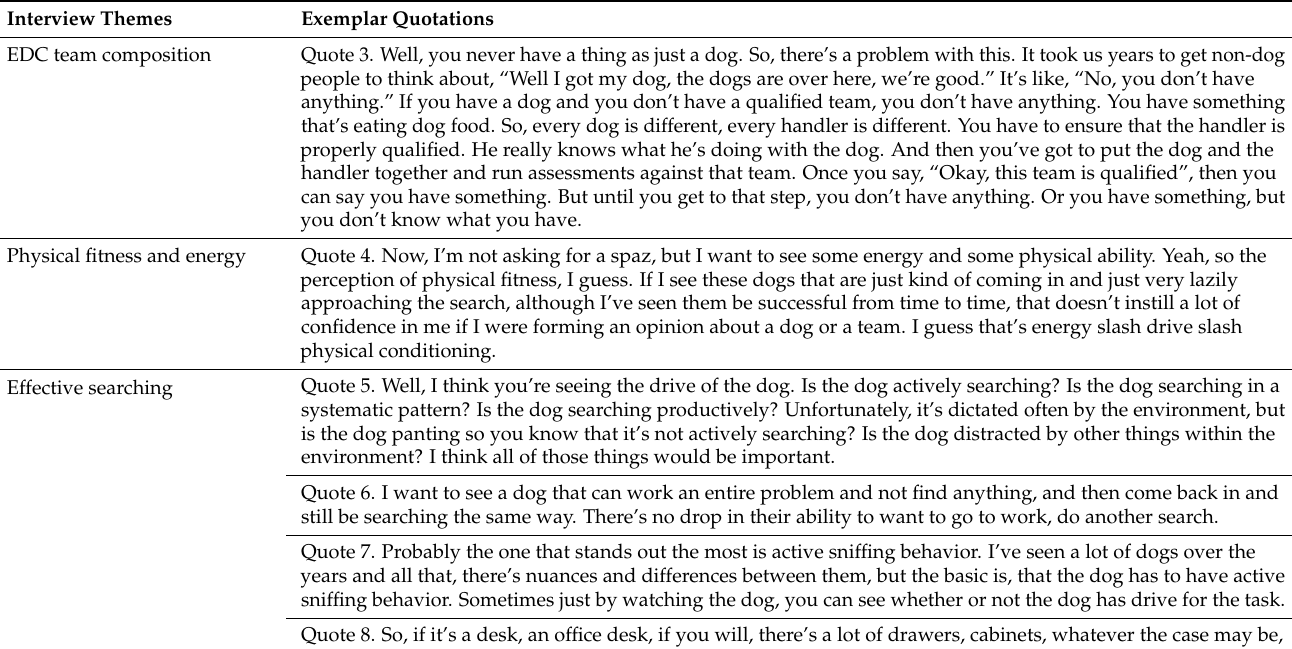
Table 2. EDC team performance interview themes and exemplar